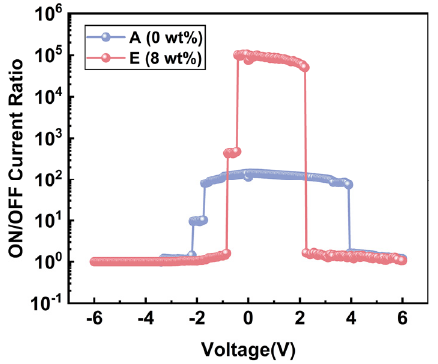
Figure 8. The switching current ratio of devices A and E.